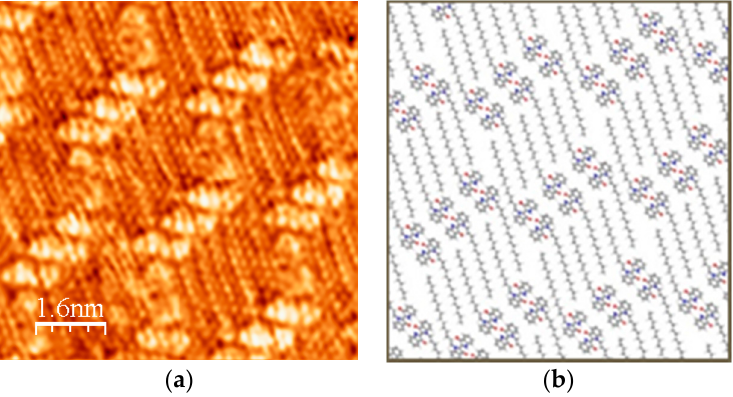
Figure A1. Dislocated structure formed by C16IND: ( a ) STM image; ( b ) structural model.